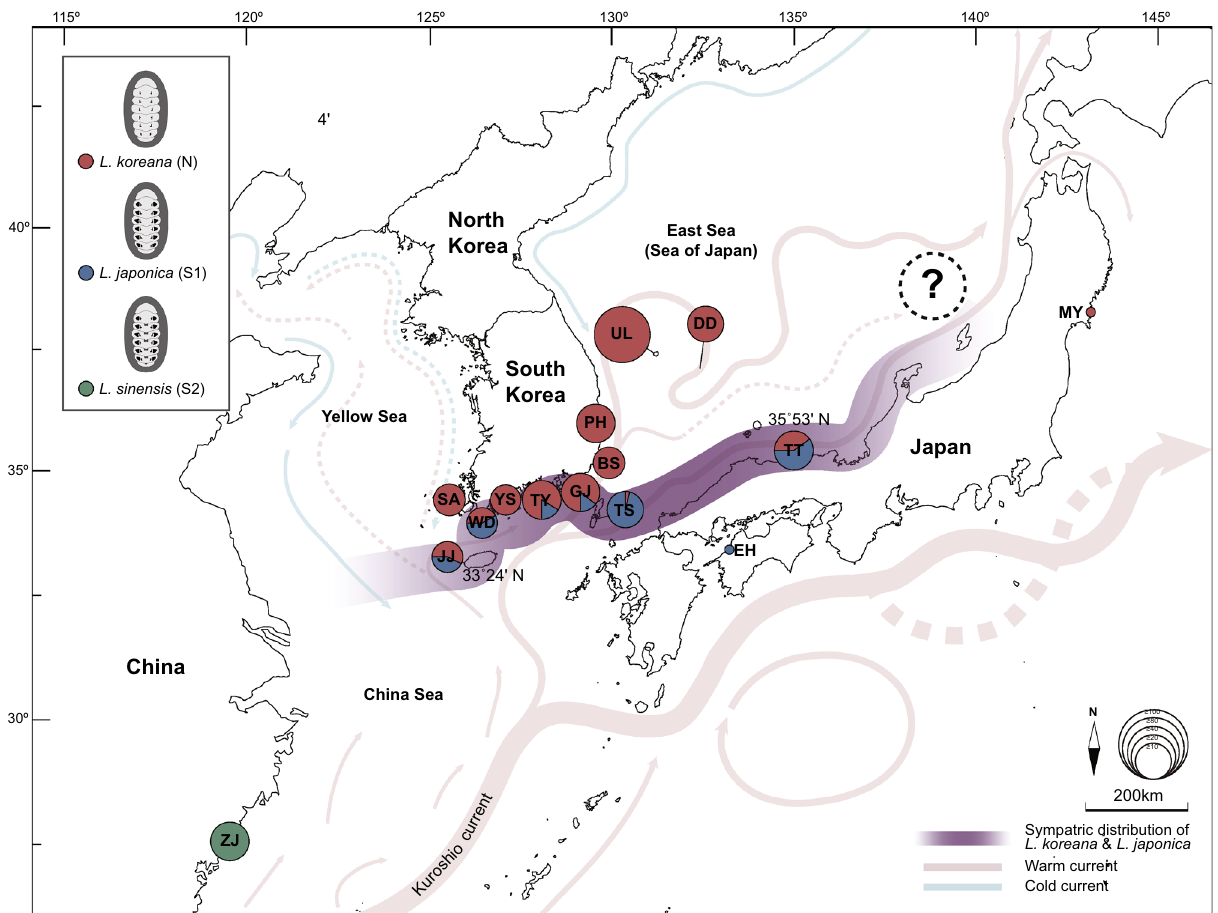
Figure 7. Geographical distribution of Liolophura koreana , sp. nov., L. japonica , and L . sinensis , sp. nov. inhabiting coastal areas of the northwestern Pacific Ocean. A COI -based map showing geographical distribution of L . koreana , L . japonica , and L . sinensis on the northwestern Pacific coast. L . koreana are found in a wide range of South Korea and Japan above ca. 33°24 ′ N (JJ), L . japonica in mainly southern coastal areas of South Korea and Japan below ca. 35°53 ′ N (TT), and L . sinensis in ZJ of southern China around ca. 27°02 ′ N–28°00 ′ N. The sympatric distribution of L . koreana and L . japonica is shown between 33°24 ′ and 35°53 ′ N. Table S1–S3 contain the full names of localities and detailed haplotype information. The question mark indicates that collection of Liolophura samples from such coastal areas in Japan is required to clarify distribution patterns of L. koreana and L. japonica in the East Sea (= Sea of Japan). The basic map was obtained from a free map-providing site (https://d- maps. com), which was modified using Adobe Illustrator v.25.2. (https:// www. adobe.